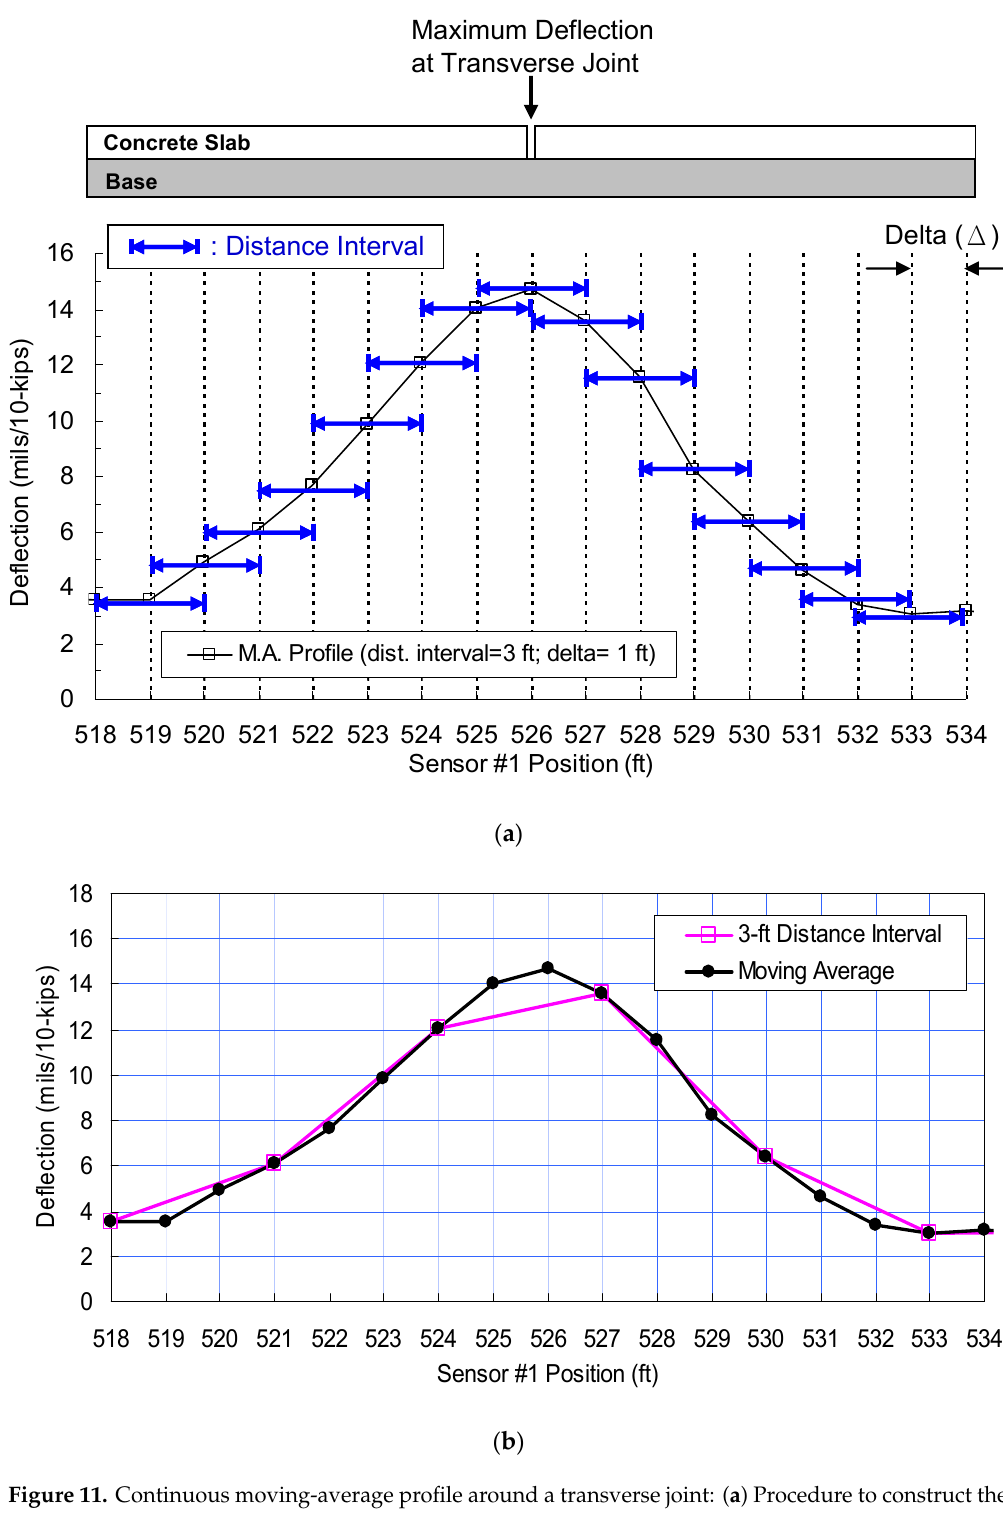
Figure 11. Continuous moving-average profile around a transverse joint: ( a ) Procedure to construct the moving average profile, and ( b ) the comparison of the moving average and the distance-based profile (with 1.5 ft spatial interval).